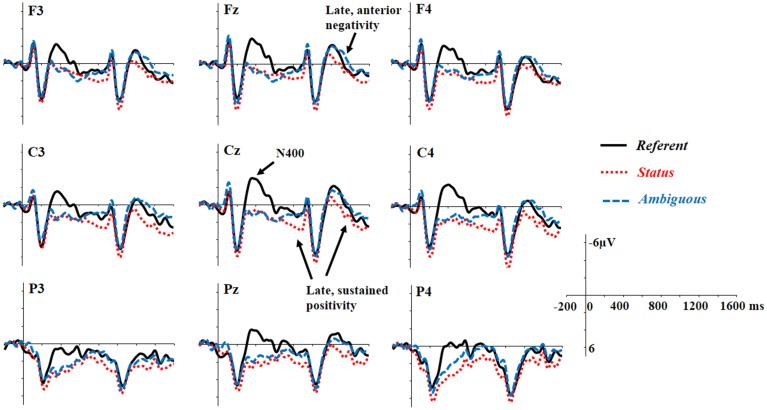
Grand average waveforms time locked to the pronoun on 9 representative electrodes for the three critical conditions.